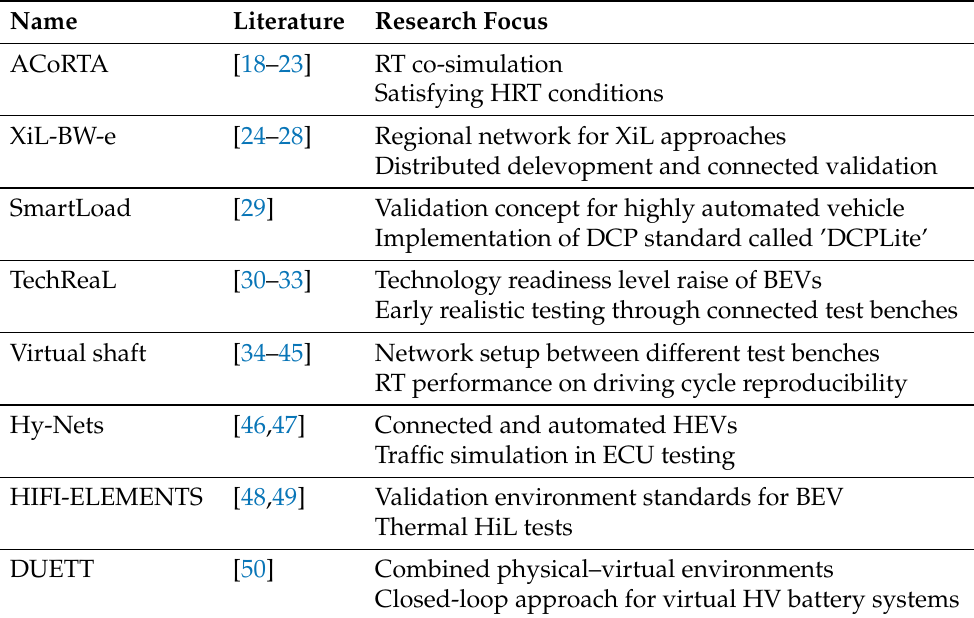
Table 1. Categorization of a literature selection on test bench coupling projects and approaches.